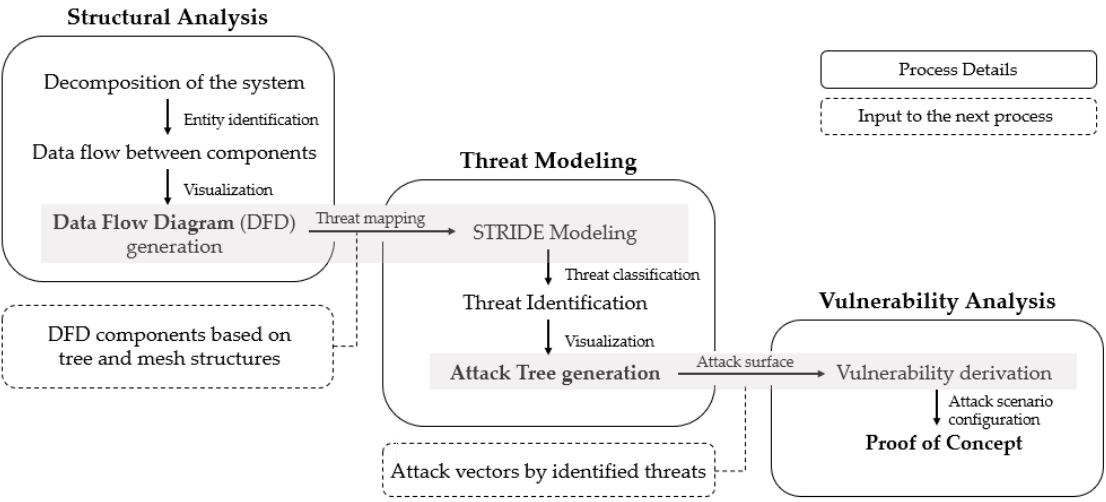
Figure 7. Vulnerability discovery framework composition.